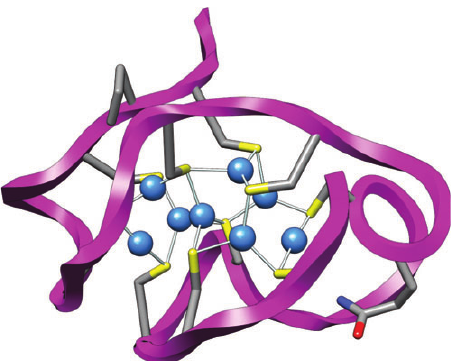
Figure 1 3D structure of the yeast S. cerevisiae Cu -Cup1 complex, 8 showing the Cu (SCys) cluster (PDB entry 1rju). The Cu(I) ions 8 10 are shown as spheres, the Cys residues as sticks, and the S-Cu bonds as solid lines. The structure was represented using the UCSF Chimera software. Chimera is developed by the Resource for Biocomputing, Visualization and Informatics at the University of